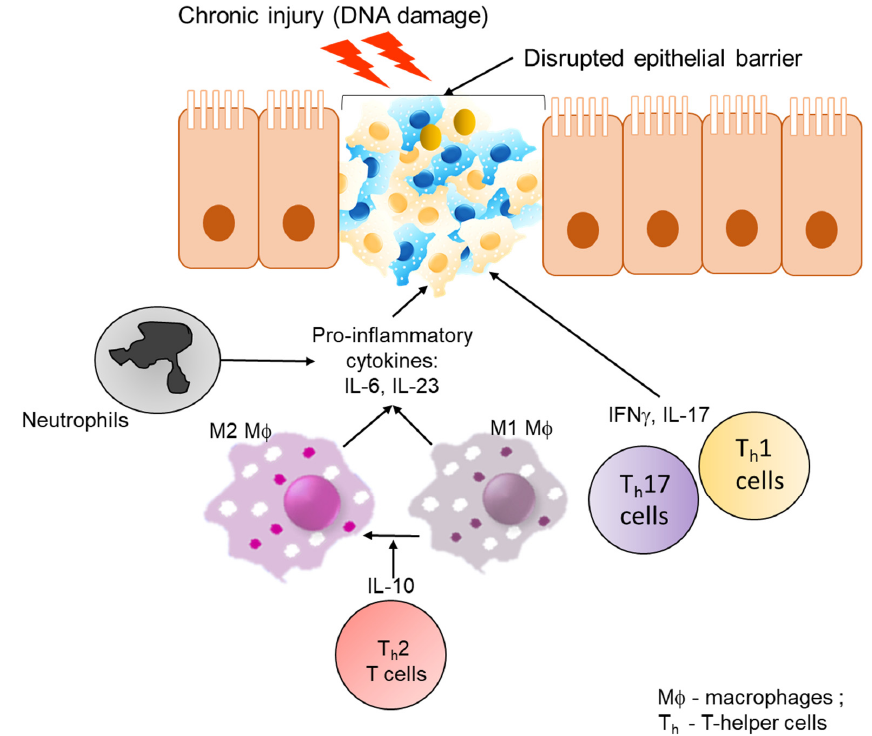
Figure 3. Role of inflammation and microbiome in colorectal cancer. Chronic DNA ‐ damage caused by infection, prolonged inflammation, and tissue injury due to barrier disruption results in activation of NF- κ B signaling in epithelial cells promoting sustained cell proliferation and evasion of apoptosis. This eventually results in oncogenic transformation of epithelial cells. Sustained signaling of IL-10 from T h 2 T cells results in di ff erentiation of macrophages from M1 (drives classical inflammatory response) to M2 (promotes immune suppression and wound healing). M2 macrophages and neutrophils secrete pro-inflammatory cytokines IL-6 and IL-23. IL-23 promotes accumulation of T h 17 T cells, which secrete IL-17 which is known to play an important role in colitis associated cancer. IL-6 levels directly contribute to the development of colorectal cancer by activation of NF- κ B and STAT3. T h 1 T cells produce IFN γ , as a protective mechanism to deal with ongoing tissue damage caused by the presence of the tumour. M φ —macrophages; T h —T-helper